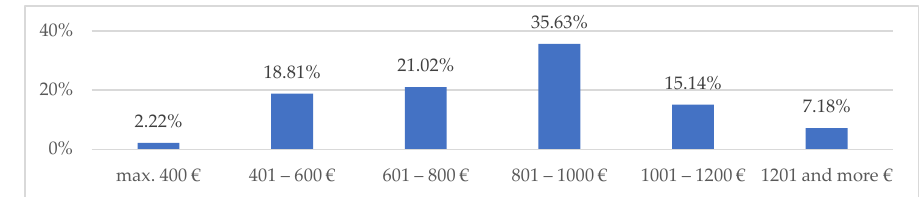
Figure 4. Monthly income of the customers of coloured wood.